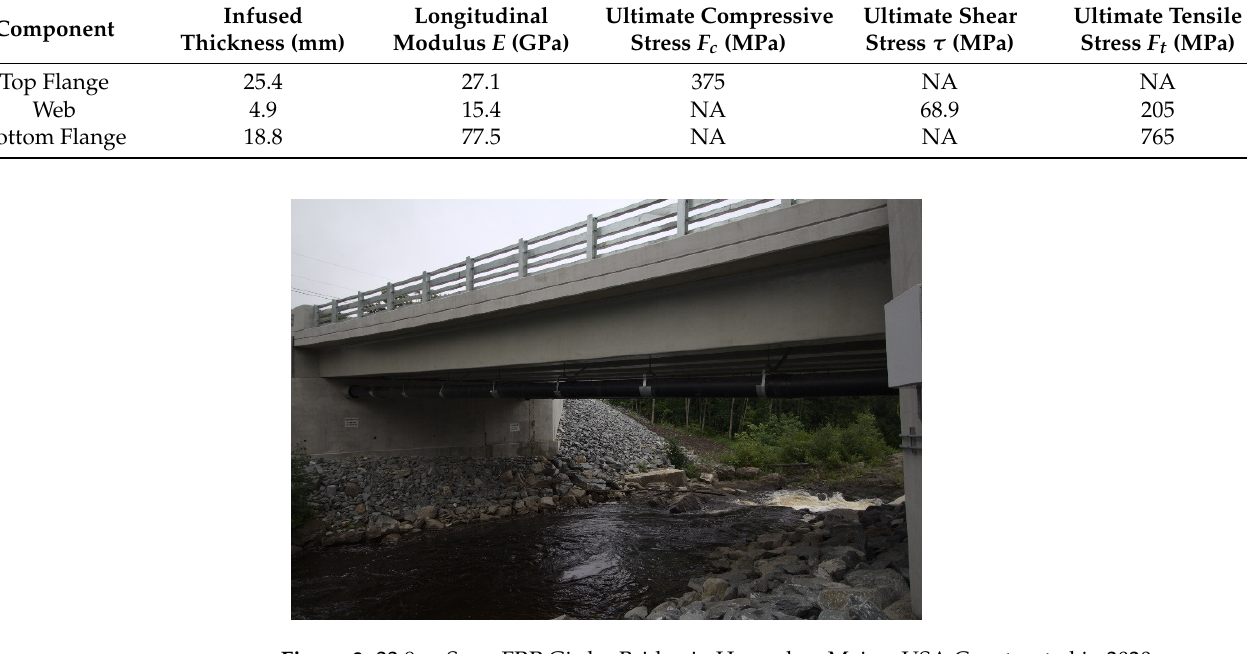
Figure 3. 22.9 m Span FRP Girder Bridge in Hampden, Maine, USA Constructed in 2020.